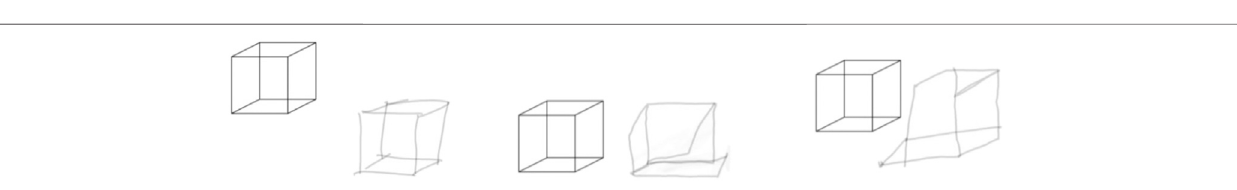
FIGURE 7 | Cube drawing based on category. From left to right: Healthy, MCI, Alzheimer.